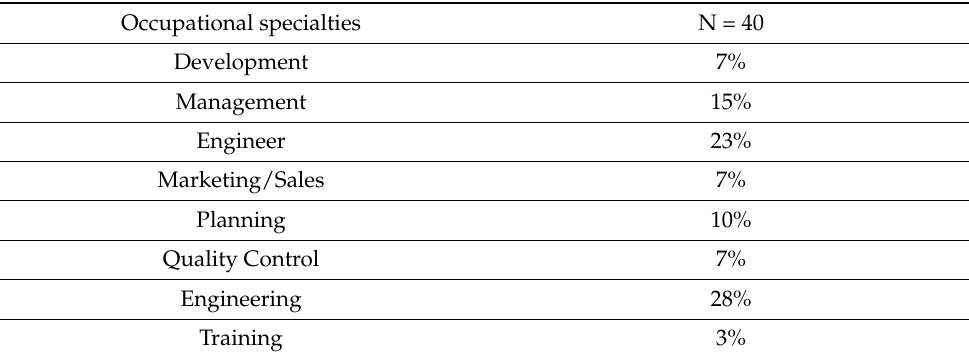
Table 5. Analysis of persona development data.—Occupational